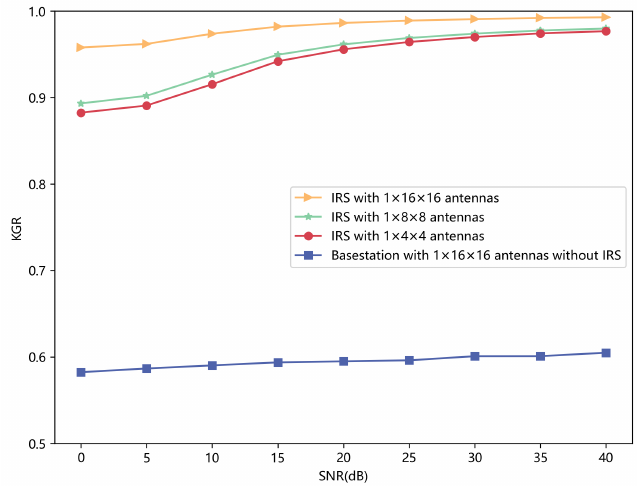
Figure 11. KGR of the initial key with a different number of antennas versus